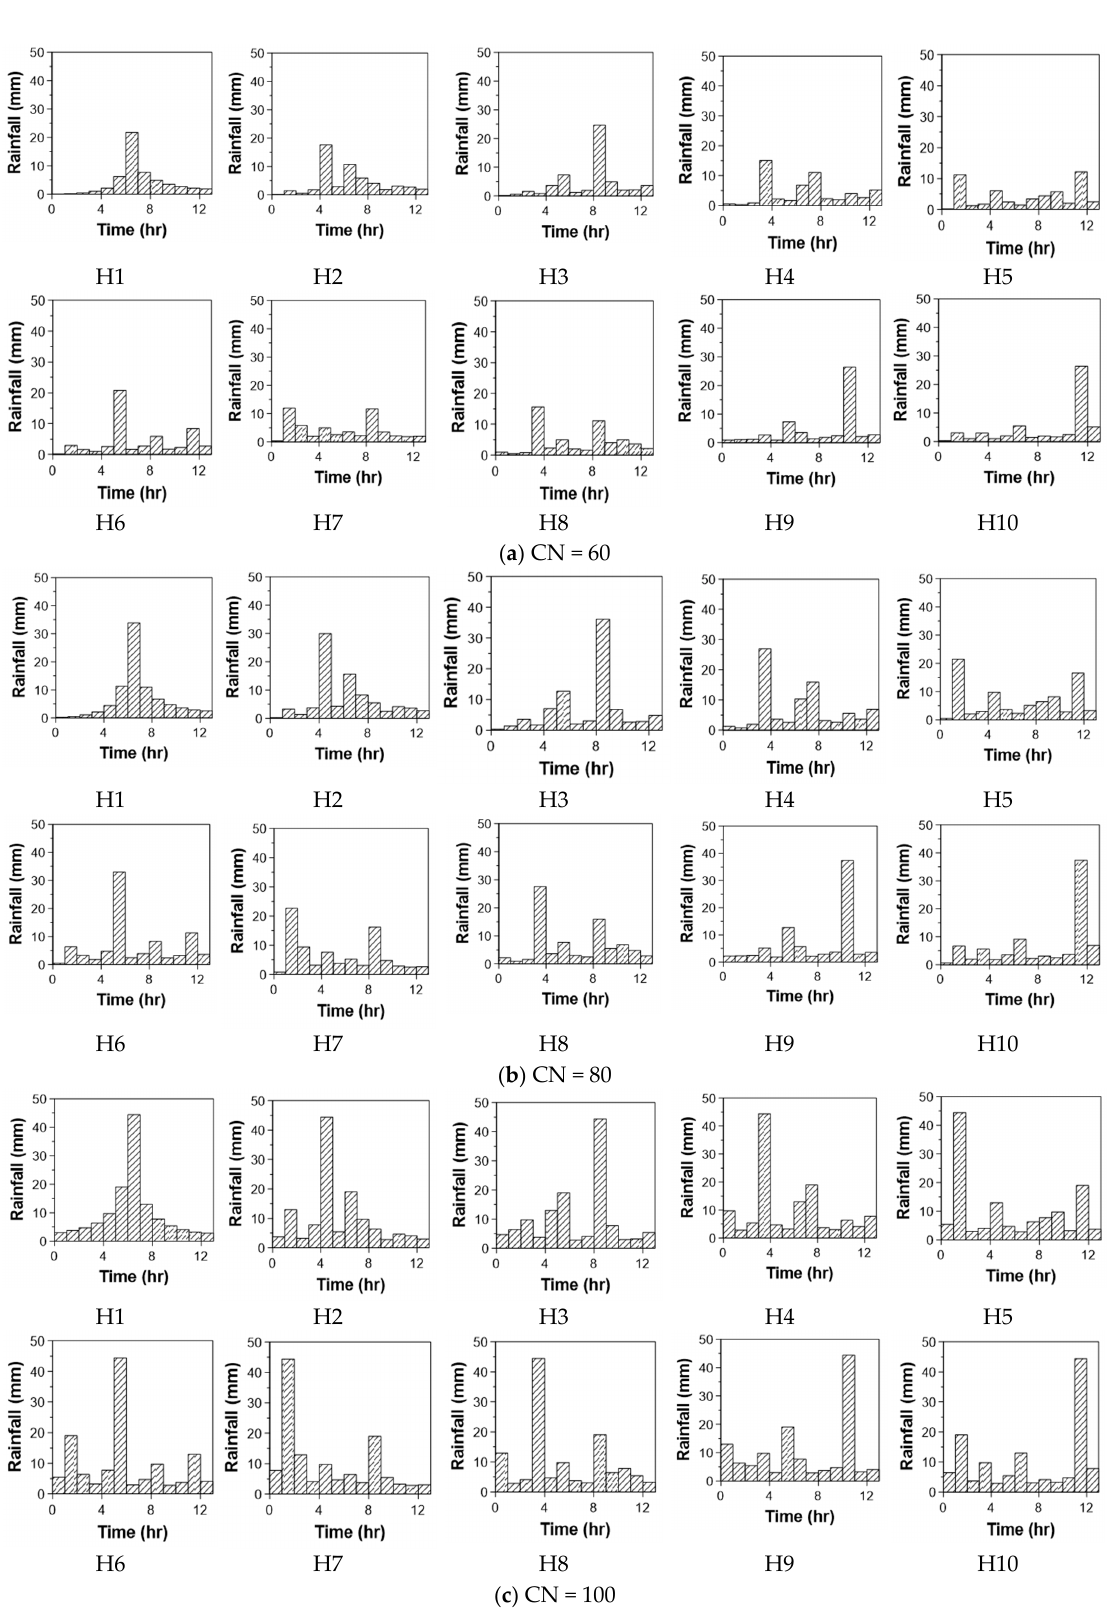
Figure 9. Randomly distributed rainfall histograms derived from the alternating block model for the annual maximum rainfall event in 1997.